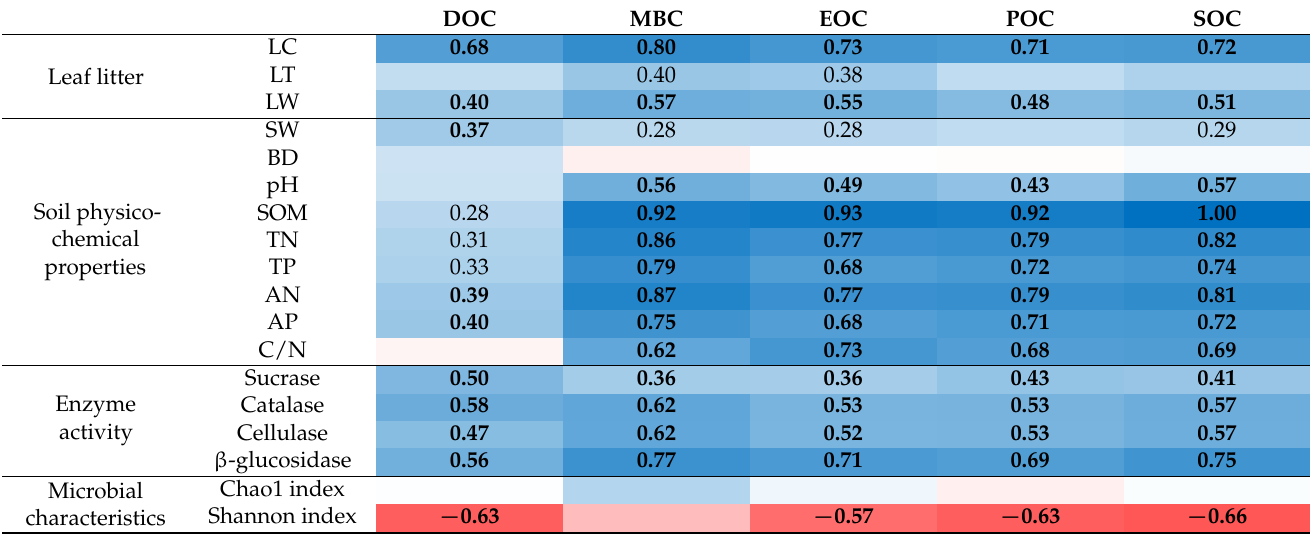
Table 3. Pearson correlation coefficients between SOC, its fractions, and environmental factors.